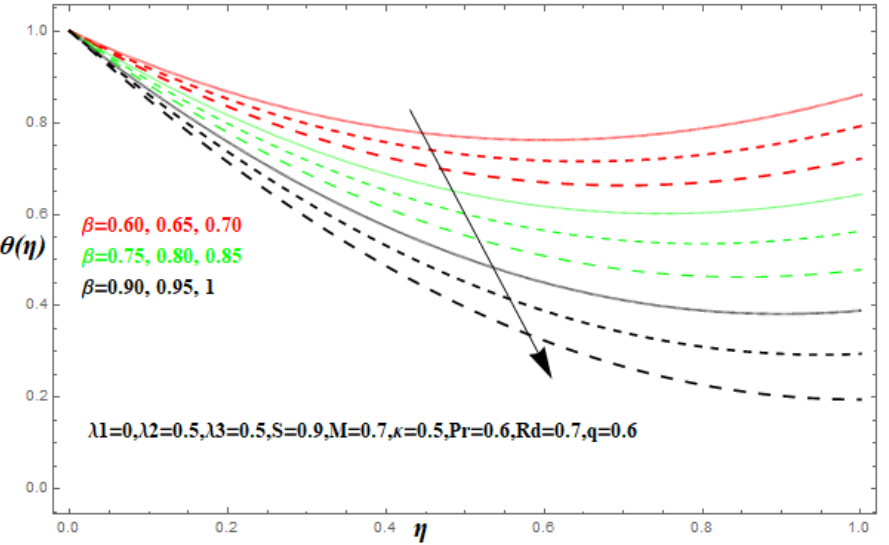
Figure 5. Variations in the temperature gradient θ ( η ) for the various measures of β .